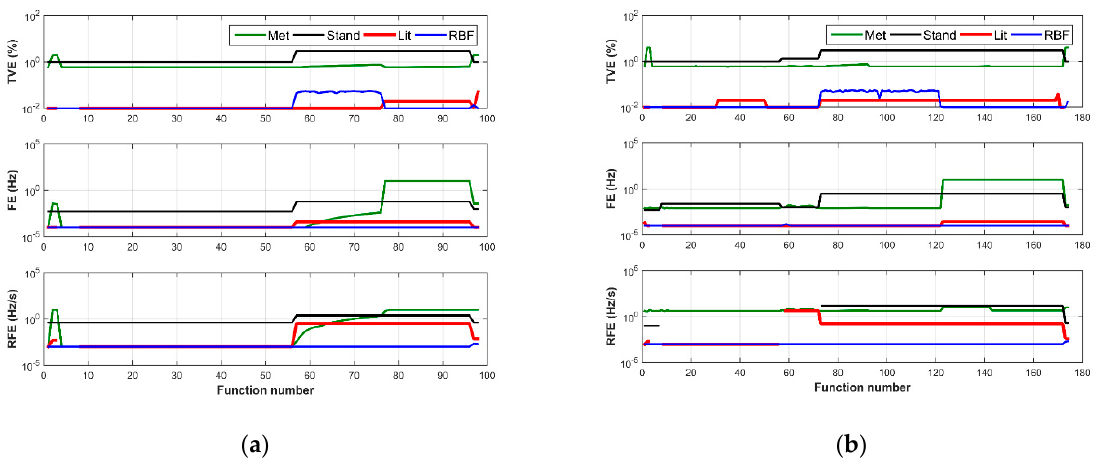
Figure 4. The TVE, FE and RFE graphs for subsequent functions: ( a ) data for the P class of the PMU device; ( b ) data for the M class of the PMU device.